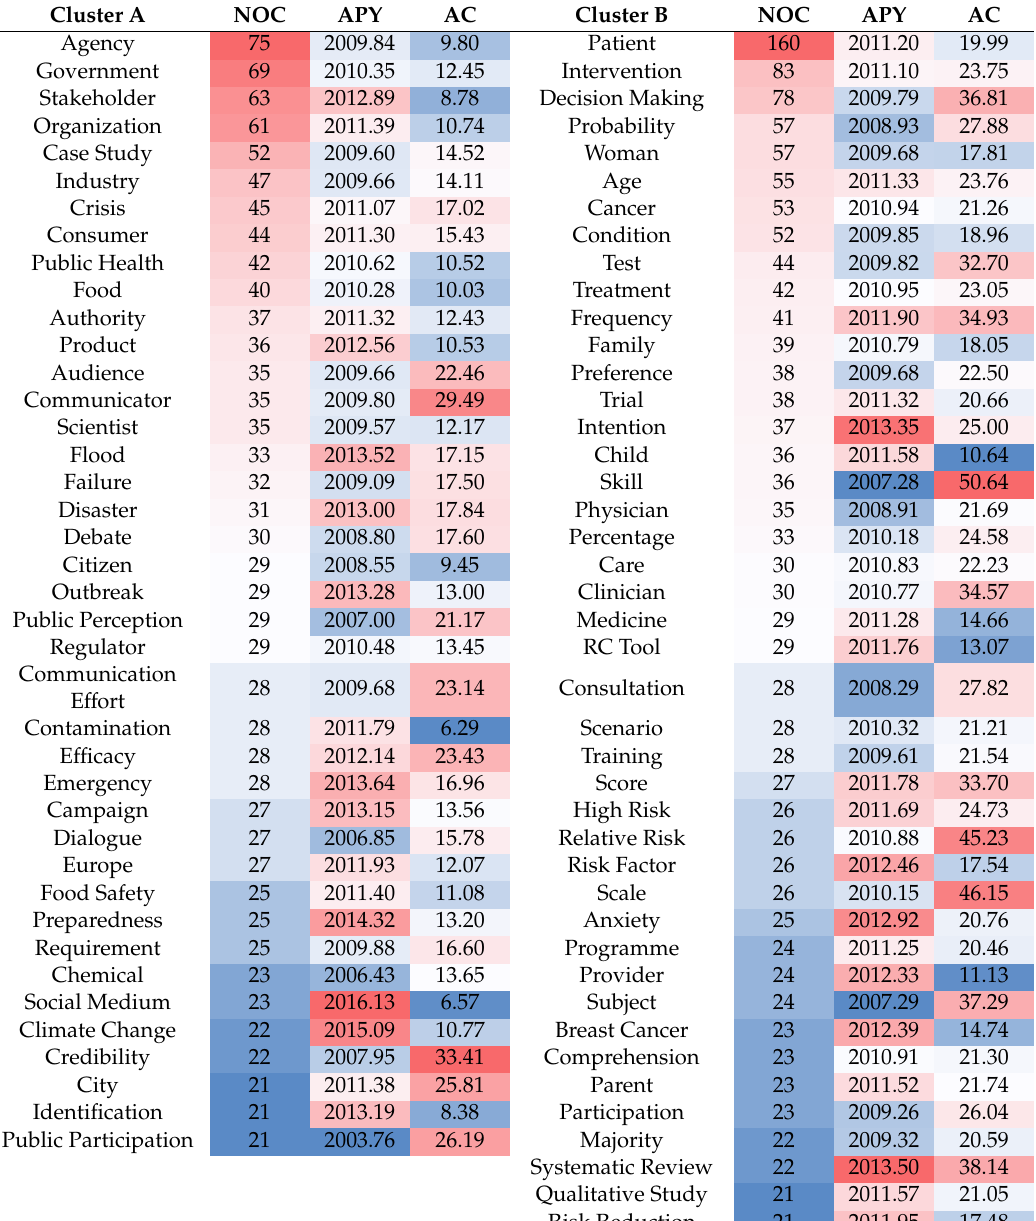
Table 7. List of risk communication terms with more than 20 term